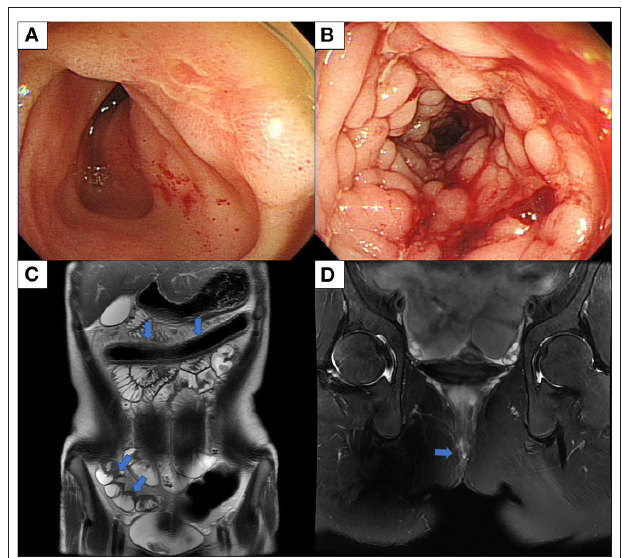
FIGURE 1 | Ileocolonoscopy and MRI conducted at diagnosis of Crohn’s disease. (A) Ileocolonoscopy revealed an ulcer in the terminal ileum, and (B) linear deep ulcers with cobblestoning in the transverse colon. (C) MRE shows multifocal asymmetric bowel wall thickening involving the transverse colon, terminal ileum, and jejunum and luminal narrowing in the transverse colon with diffusion restriction and enhancement. (D) MRI of the pelvis shows two intersphincteric perianal fistulas. MRI, magnetic resonance imaging; MRE, magnetic resonance enterography.